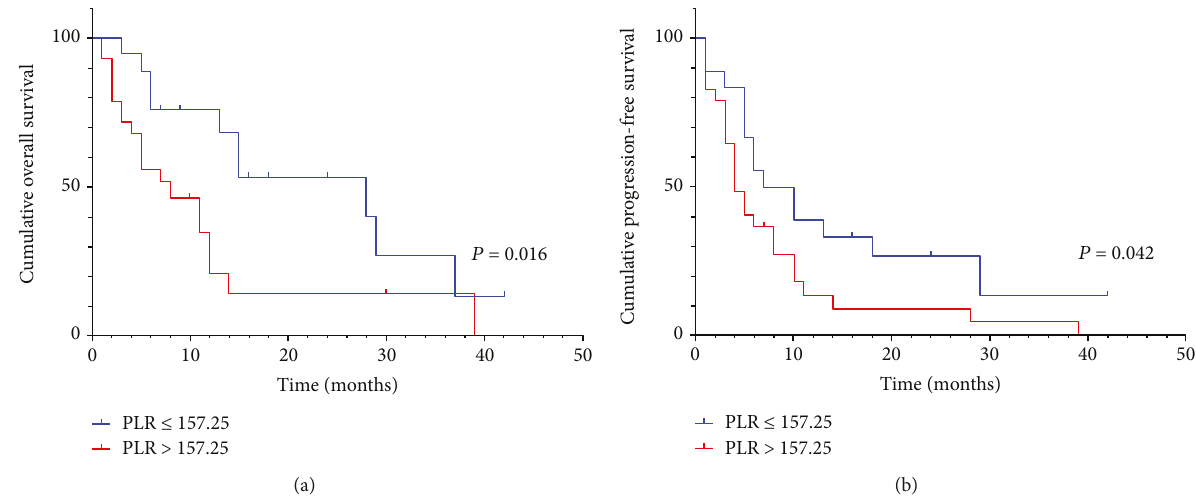
Figure 3: (a) Kaplan – Meier curve for OS and PFS of 47 CCA patients strati fi ed by lymphatic metastasis and/or positive surgical margin. (b) Kaplan – Meier curve for PFS of 47 CCA patients strati fi ed by lymphatic metastasis and/or positive surgical margin.